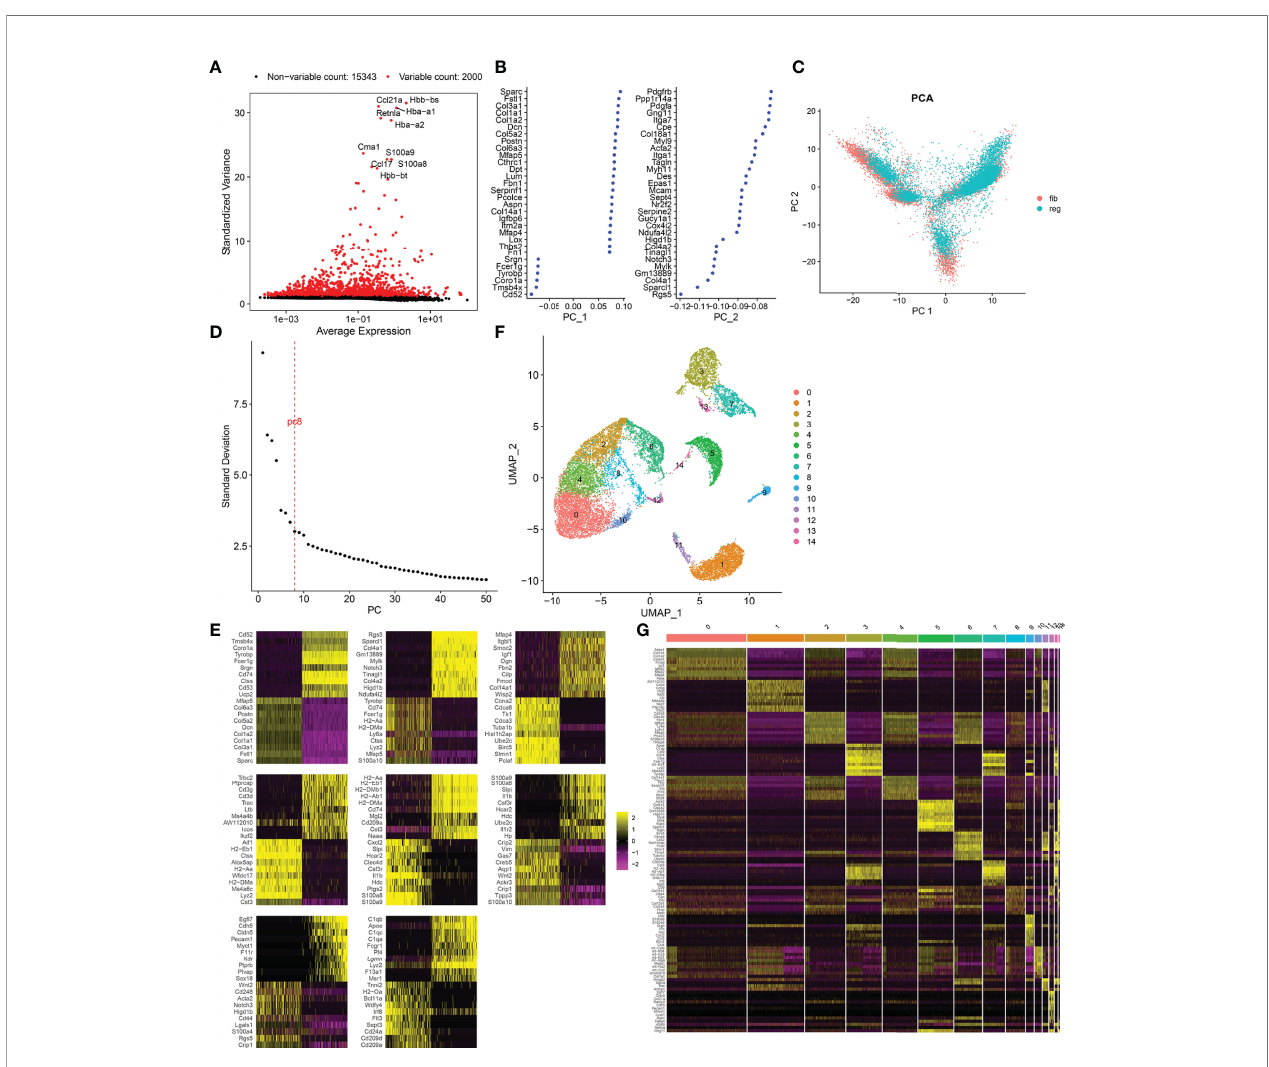
FIGURE 1 | Cell cluster of fi brotic and regenerative wound dermal cells. (A) The top 2,000 highly variable genes across fi brotic and regenerative wound dermal cells according to standard deviation. Red dots meant highly variable genes. The top ten highly variable genes were marked. (B) Two of the most principal components according to standard deviation. (C) PCA plots of wound dermal cells between fi brotic ( fi b) and regenerative (reg) conditions. Reference atlas was colored by tissue of origin ( fi brotic and regenerative wounds). (D) Determination of the optimal principal components through elbow plot. (E) Heatmaps showing the top 20 marker genes in each principal component. (F) Cell cluster based on the screened principal components. (G) Heatmap showing the expression patterns of the top ten marker genes in each cell